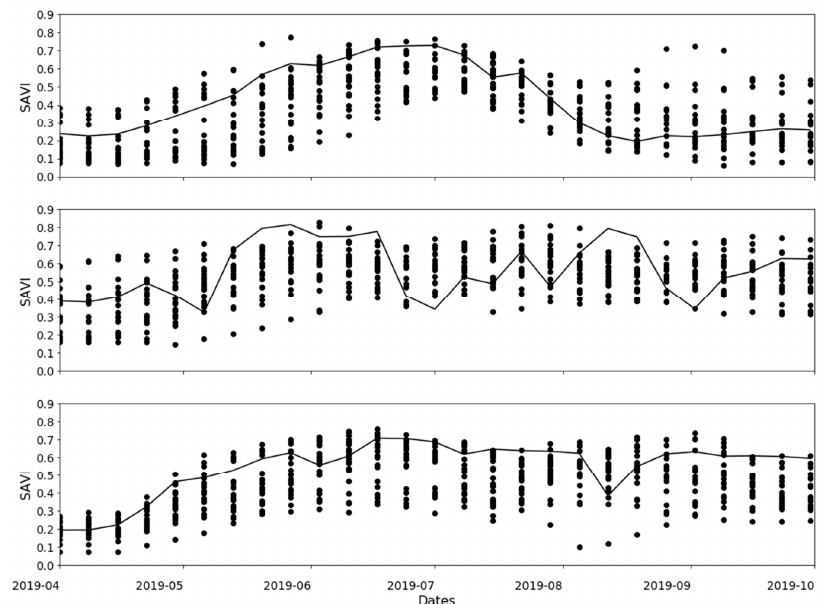
Figure 3. The temporal signatures of the Soil Adjusted Vegetation Index (SAVI) of the three land use classes, i.e., cereal (top), grass (middle) and unused (lower), as obtained from their respective typical pixels (dashed lines) and sample pixels (scattered plots).